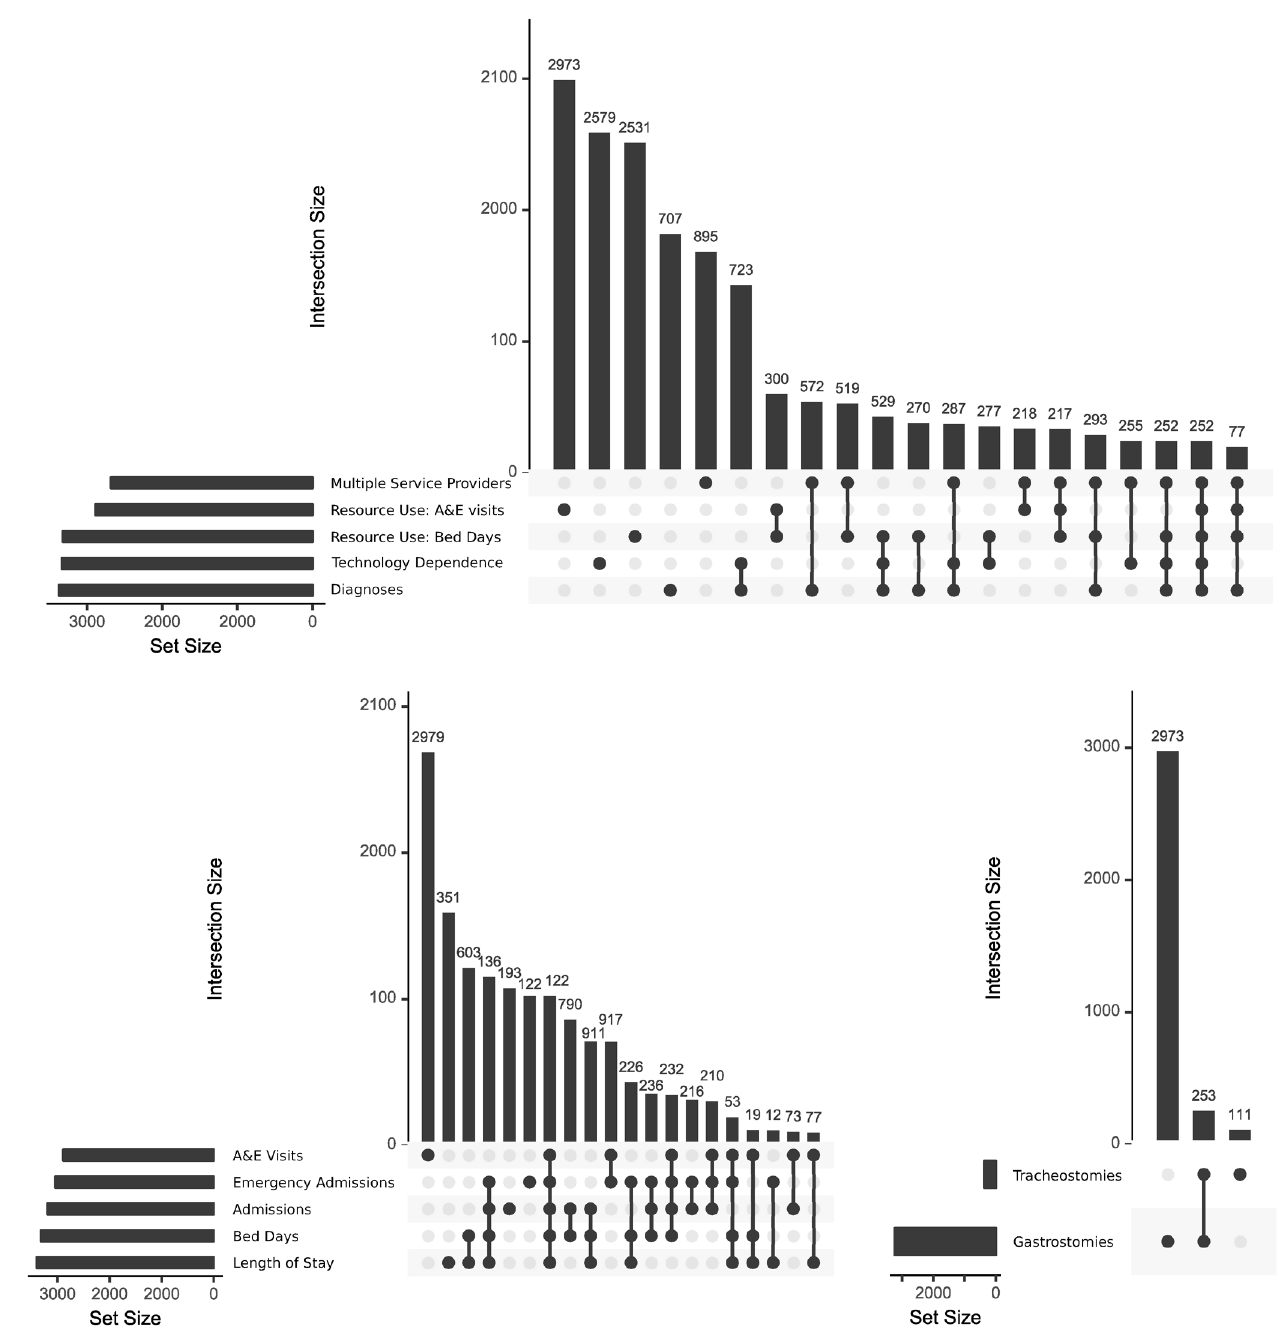
Figure 10. UpSet graphs showing relations between measures of complexity. Intersections between (top) those in approximately the top 10% for each of five indicators of complexity; (bottom left) those in approximately the top 10% in each of the five indicators of high resource use; (bottom right) those with technology dependence. For simplicity, only the largest 20 intersections are shown.